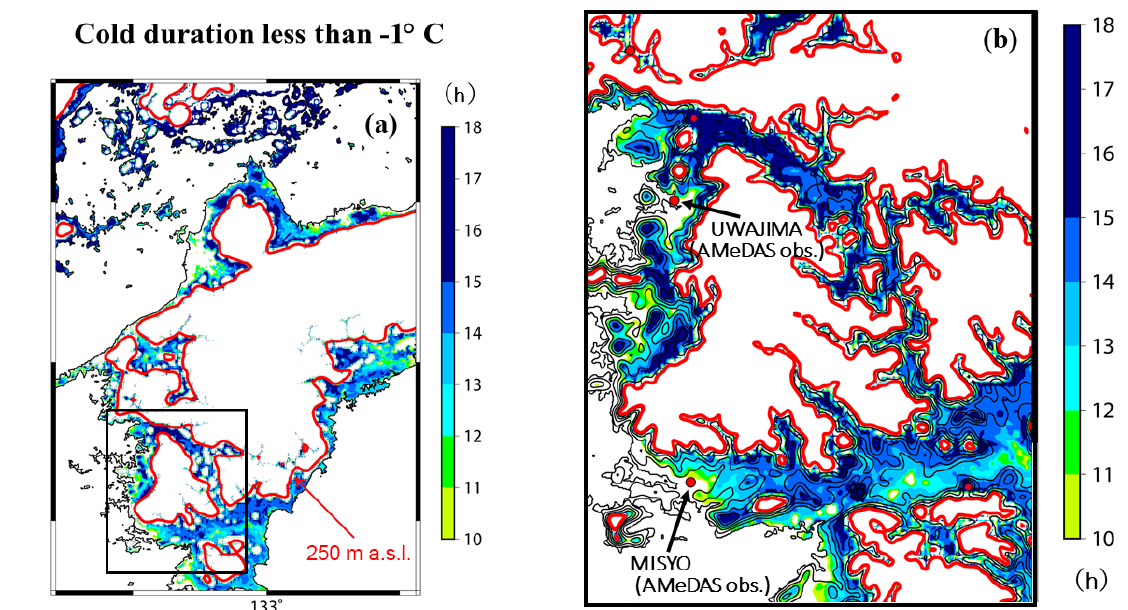
Figure 4. Simulated maps of cold duration (h) less than − 1 ◦ C, which were produced for the (a) d02 entire domain and (b) enlarged rectangle area in the left